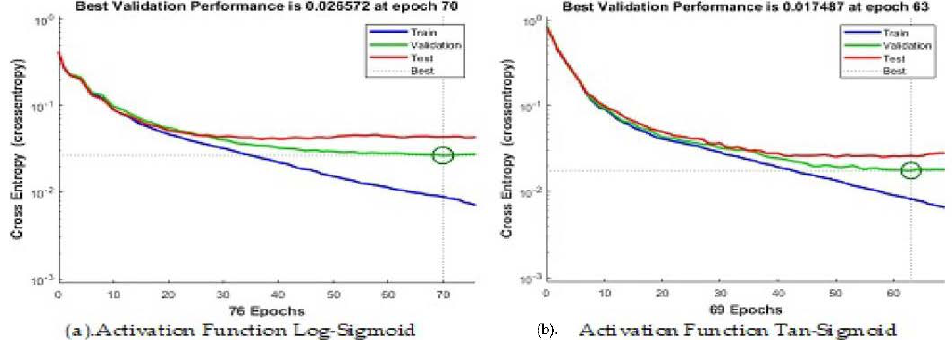
Figure 6. The error convergence and optimization current using different activation functions and neurons = 100.